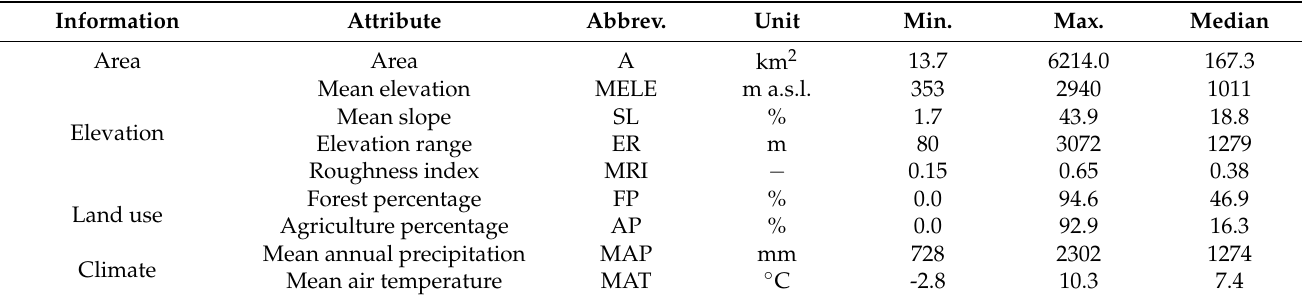
Table 1. Basic catchment